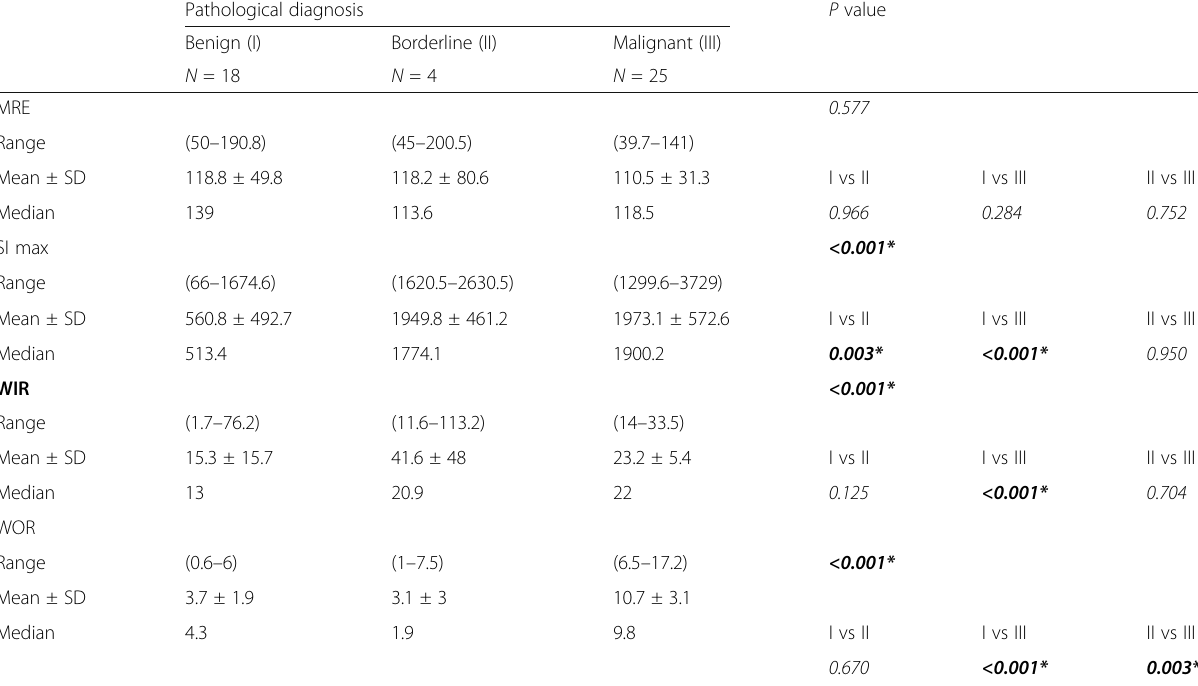
Kruska-Wallis test for nonparametric quantitative data between the three groups followed by Mann-Whitney test between each two groups. Fisher exact test for qualitative data between the groups *Significant level at P value